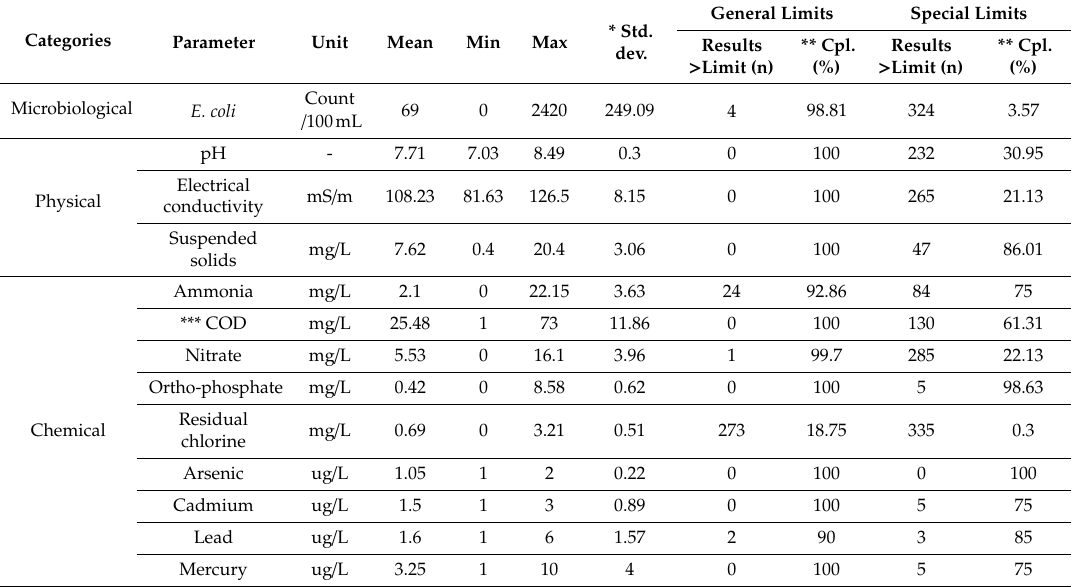
Table 2. Physical parameters compliance to South African General Authorizations